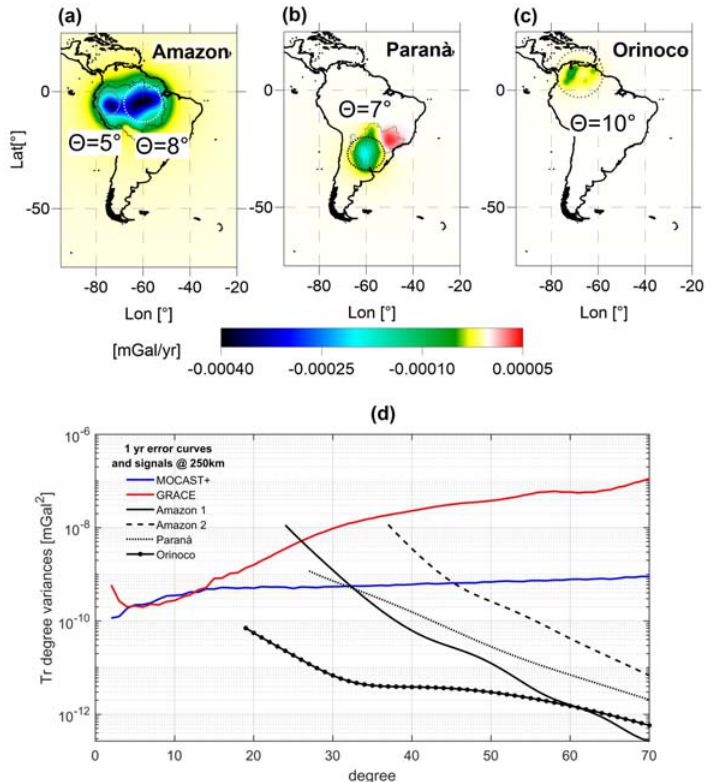
Figure 10. ( a – c ) Long ‐ period gravity rates in the three basins considered and the outline of the caps used for the localized spectral analysis. Calculations at 250 km altitude. ( d ) Spectra of long ‐ period yearly rates in 3 South American hydrologic basins considered (black lines). Rates expressed as the gravity change accumulated in one year. Error curves of MOCAST+ (blue) and GRACE (red). Spectra calculated at 250 km altitude.